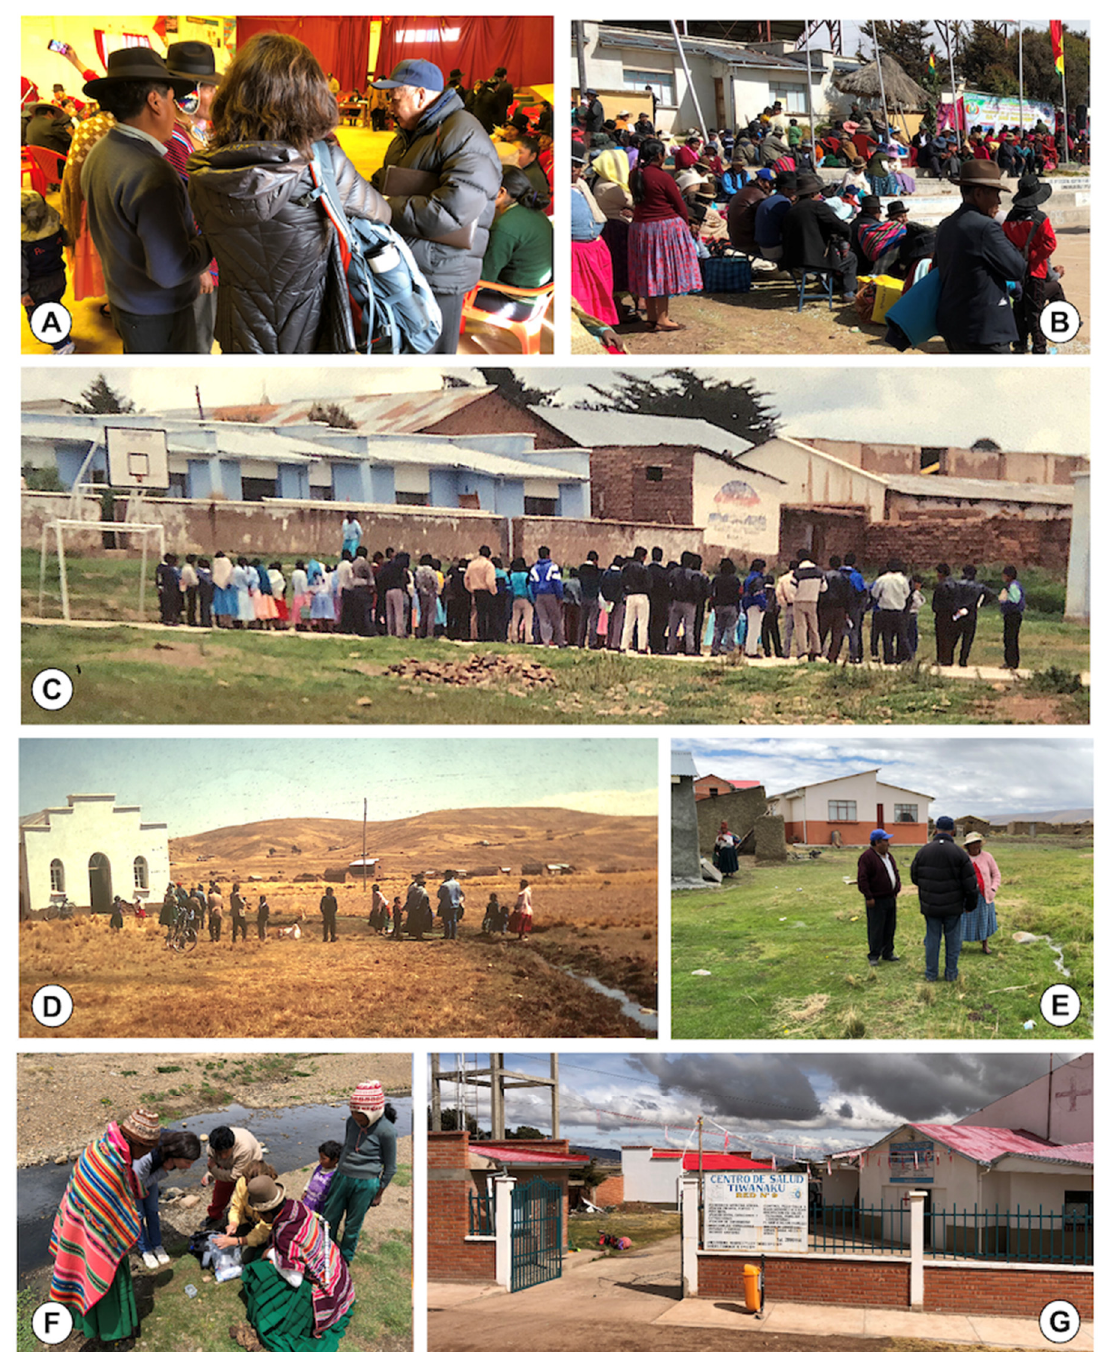
Figure 3. Ethnographic fieldwork: ( A ) Explaining project activities and aims to local Aymara community chiefs (jilakatas and mallkus), in Huacullani; ( B ) Meetings with parents and old people to let know about the disease in Huacullani; ( C ) Giving instructions to children in school, in Huacullani; ( D ) Taking advantage of church visits on Sunday morning for community interviews, in Chojasihui; ( E ) Individual interviews allowed for deeper questioning and fruitful information, in Suriquiña; ( F ) Field teaching of women and children, in charge for livestock grazing, on how to distinguish fascioliasis transmission foci by lymnaeid snail detection, in Challapata; ( G ) Rural health centres in the endemic area were visited for interviews of local physicians and nurses, in Tiwanaku. Photographs S. Mas-Coma.